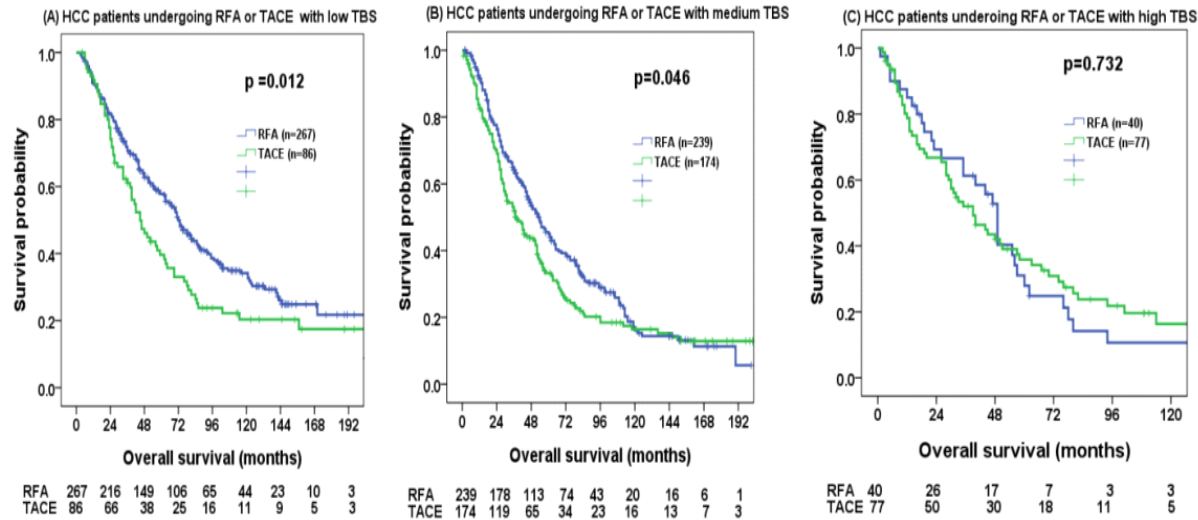
Figure 3. Comparison of overall survival in patients within the Milan criteria undergoing radiofrequency ablation (RFA) and transarterial chemoembolization (TACE) based on ( A ) low TBS, ( B ) medium TBS, and ( C ) high TBS. RFA group had a better survival compared with TACE group in patients with low and medium TBS (both p < 0.05).